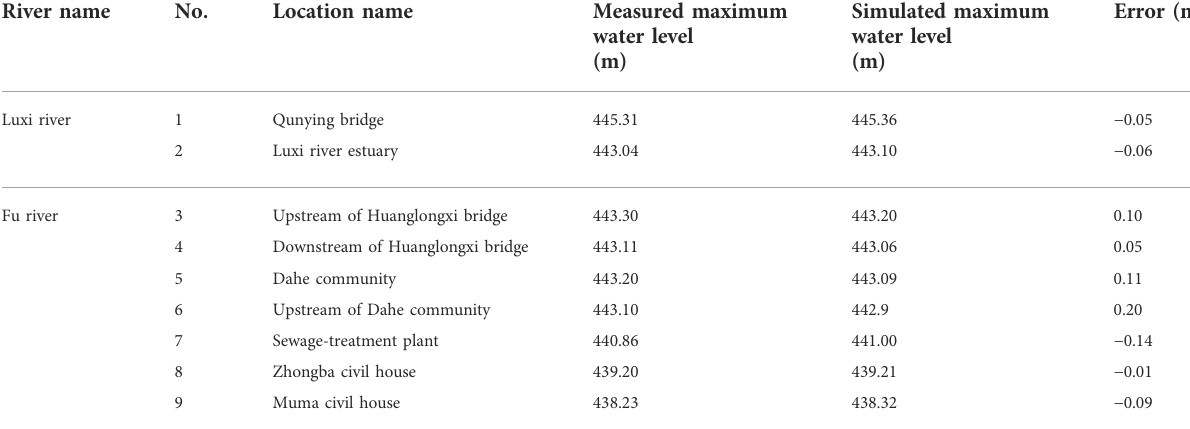
TABLE 2 Comparison of simulated and measured water levels at fl ood mark points.